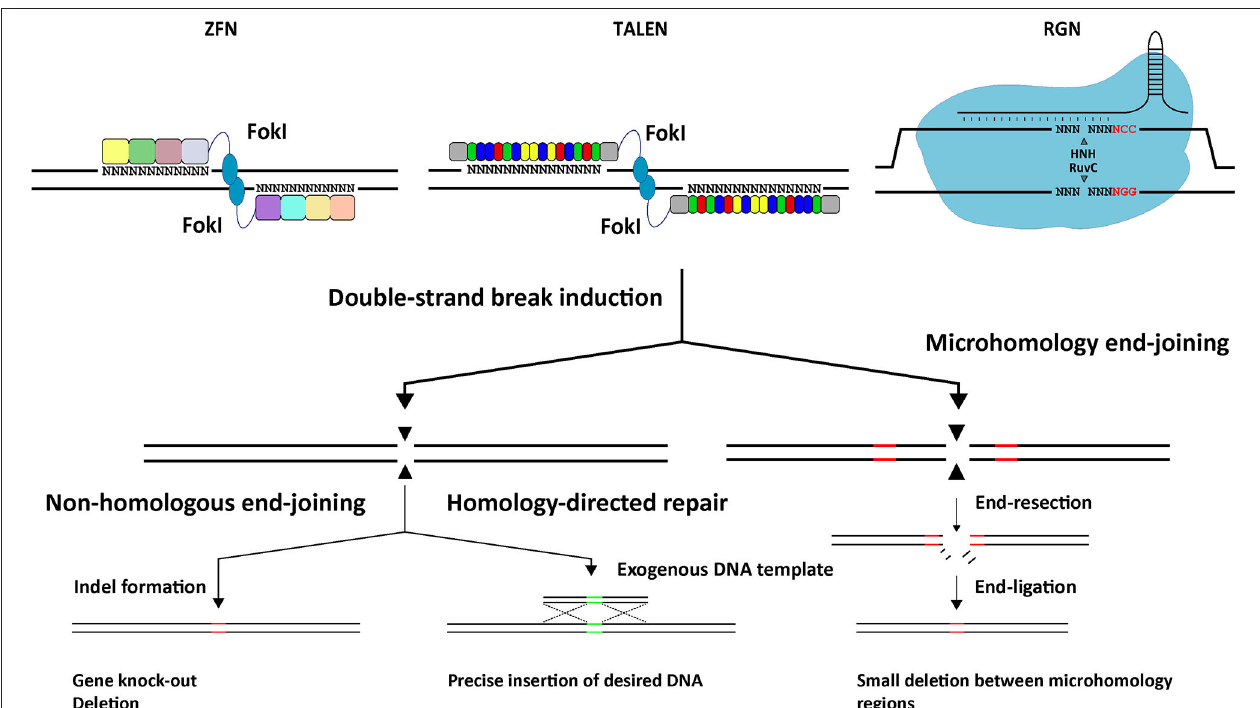
FIGURE 4 | Schematic representation of the three main classes of programmable nucleases (i.e., ZFNs, TALENs, and RGNs based on the prototypic S. pyogenes CRISPR-Cas9 system) and the DNA repair pathways underlying different gene editing outcomes resulting from the induction of targeted double-strand breaks. See text for